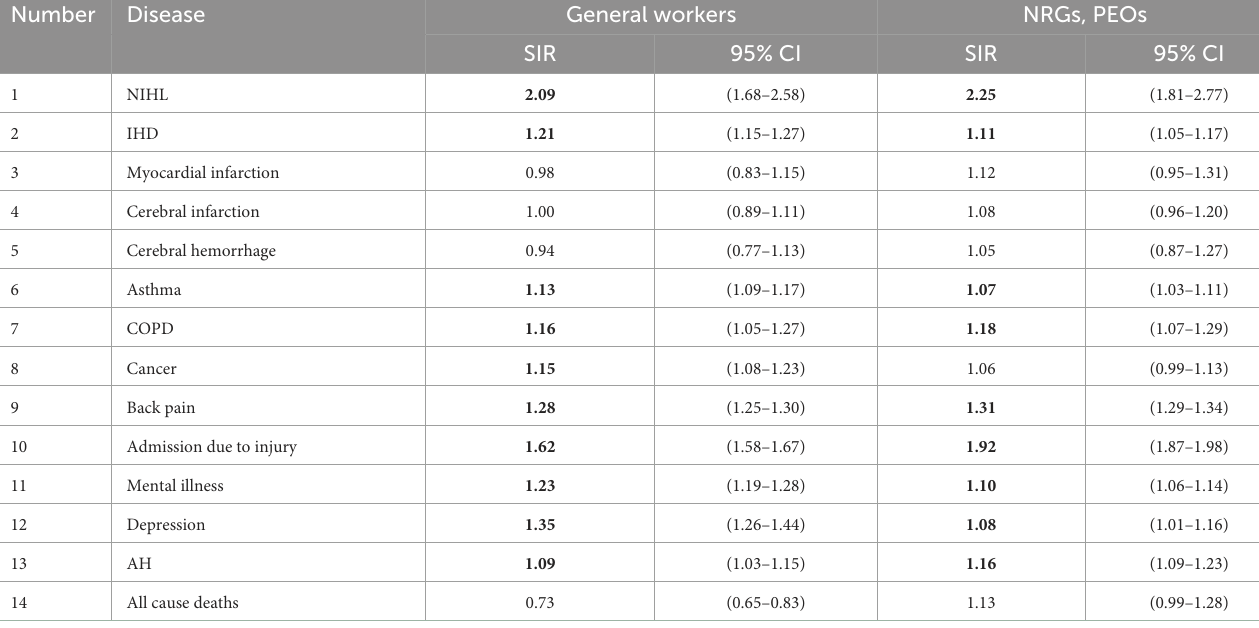
TABLE 3 Standardized incidence ratios of firefighters compared to general workers, national regional government officers, and public educational officers.